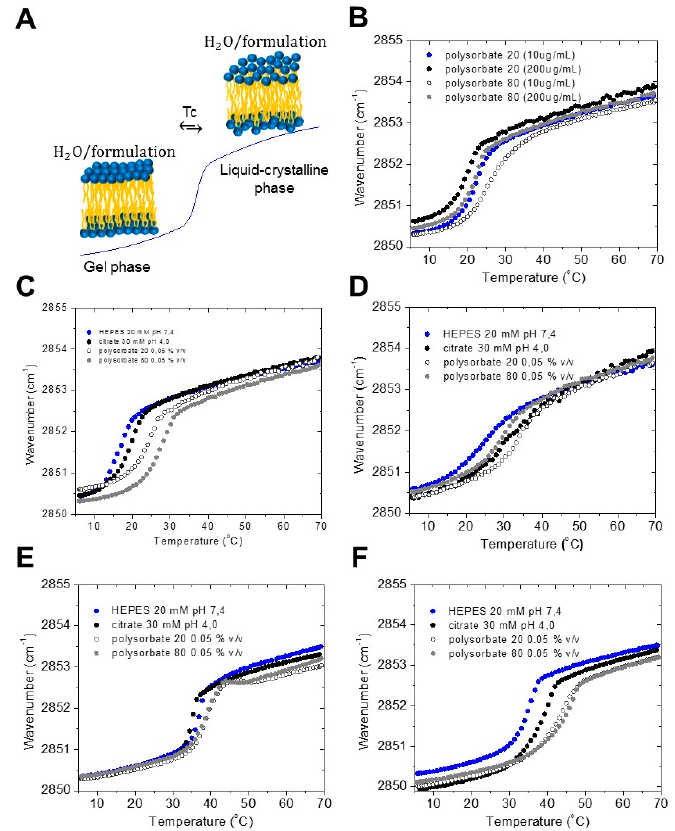
Figure 1. Effect of the formulation on the gel to liquid crystalline phase transition of lipopolysaccharides (LPS). ( A ) Schematic representation of the gel to liquid-crystalline phase transition of a lipid bilayer. Phase transitions of ( B ) LPS from E. coli O111:B4 in two different concentration of polysorbate 20 and 80; ( C ) LPS from E. coli O111:B4 in different formulations; ( D ) LPS from E. coli 055:B5 in different formulations; ( E ) LPS from S. minnesota Rb mutant strain R345 in different formulations; and, ( F ) LPS from S. minnesota Rd-mutant strain R7 in different